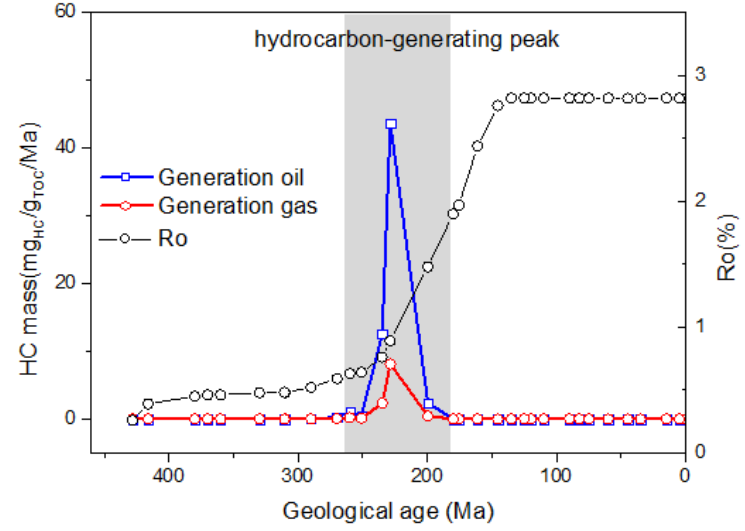
Figure 8. Modeling results of well CN. Calibration of the modeled vitrinite reflectance values and evolution of the oil and gas generation rates of the O 3 w–S 1 l shales.